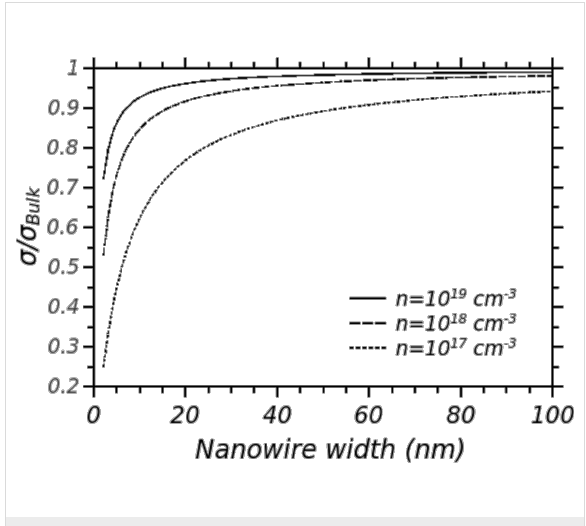
Figure 6: Electrical conductivity σ of a silicon nanowire as a function of the nanowire width (triangular cross section), normalized with respect to the bulk electrical conductivity σ Bulk